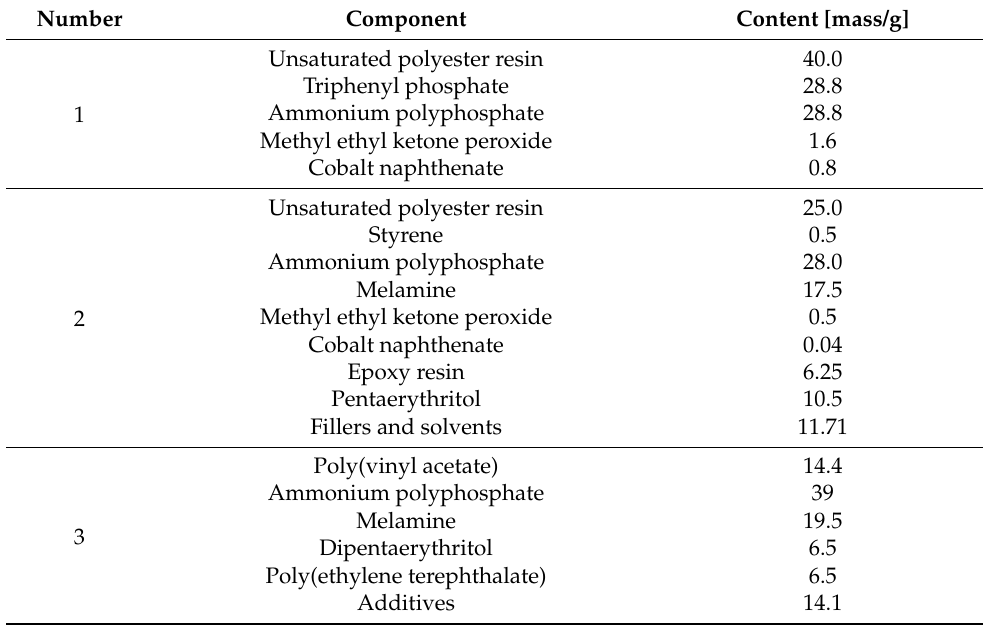
Table 2. Compositions of intumescent paints and UPR/IFR composite